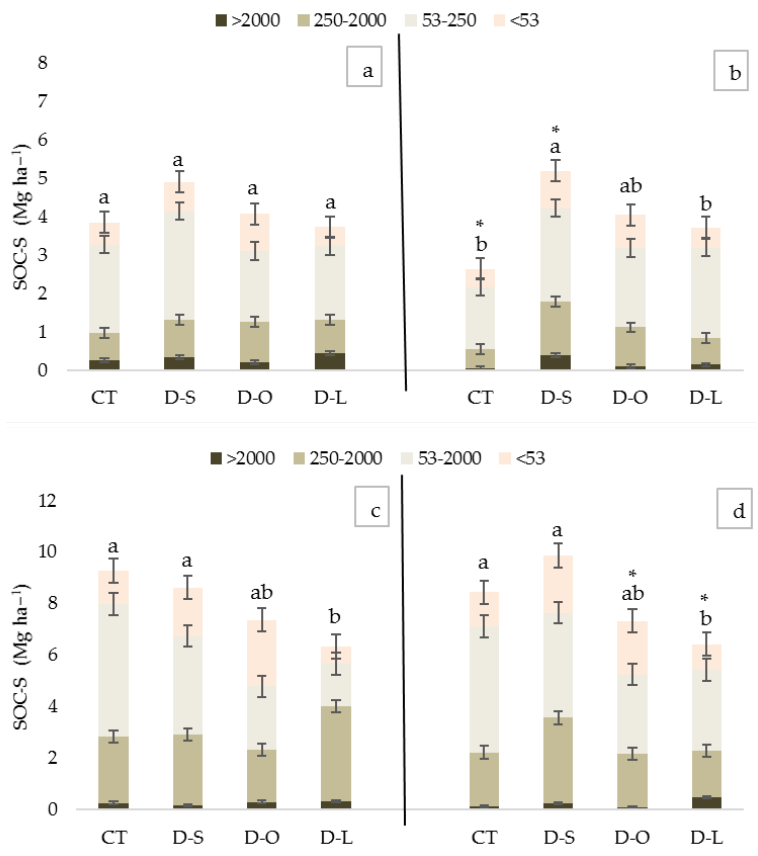
Figure 8. Aggregate-associated soil organic carbon stocks (SOC-S) distribution (Mg ha − 1 ) within soil water-stable aggregates for conventional-tillage (CT); saffron (D-S); oats (D-O) and lavender (D-L) treatments at ( a ) 0–10 cm depth (2018), ( b ) 0–10 cm depth (2021), ( c ) 10–30 cm depth (2018) and ( d ) 10–30 cm depth (2021). The different lowercase letters above the error bars for the same soil layer indicate significant differences between managements at p < 0.05. Each cultivation system (*) represents significant differences with respect to the olive monocrop conventional tillage system in 2018 (control treatment) by Dunnett’s test (* p < 0.05). Missing asterisks denote non-significant differ- ences.